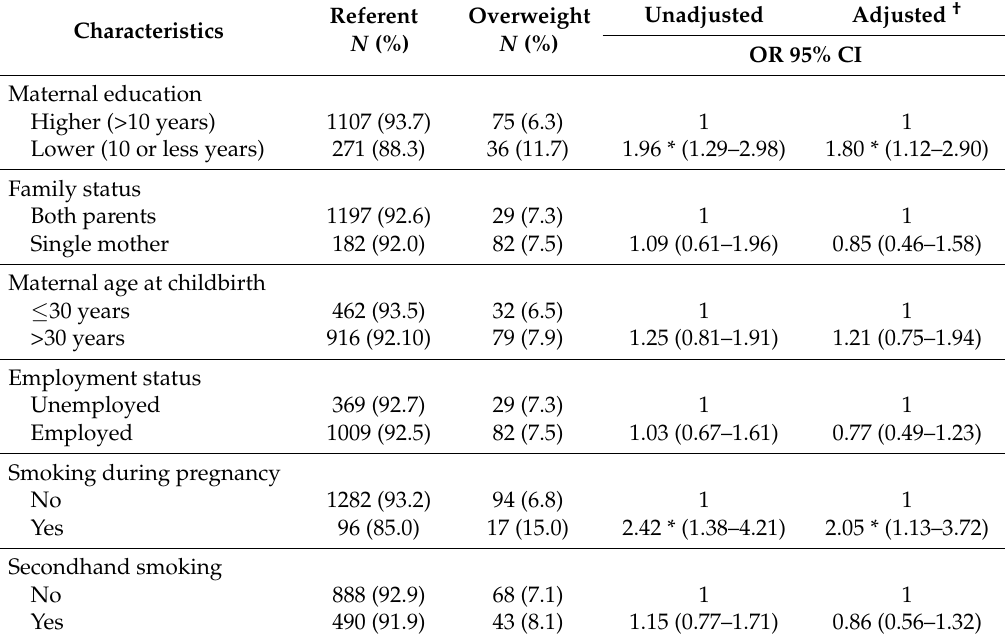
Table 2. Unadjusted and adjusted associations between the participant’s characteristics and children’s